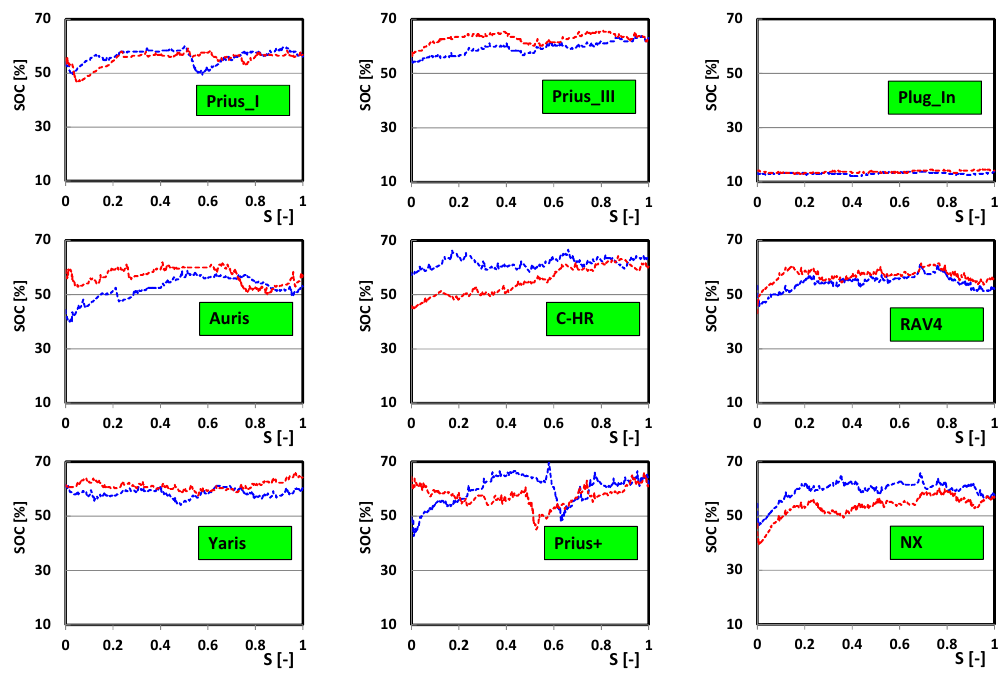
Figure 4. Variation analysis of battery state of charge resulting from the condition of vehicle movement in relation to the distance traveled.